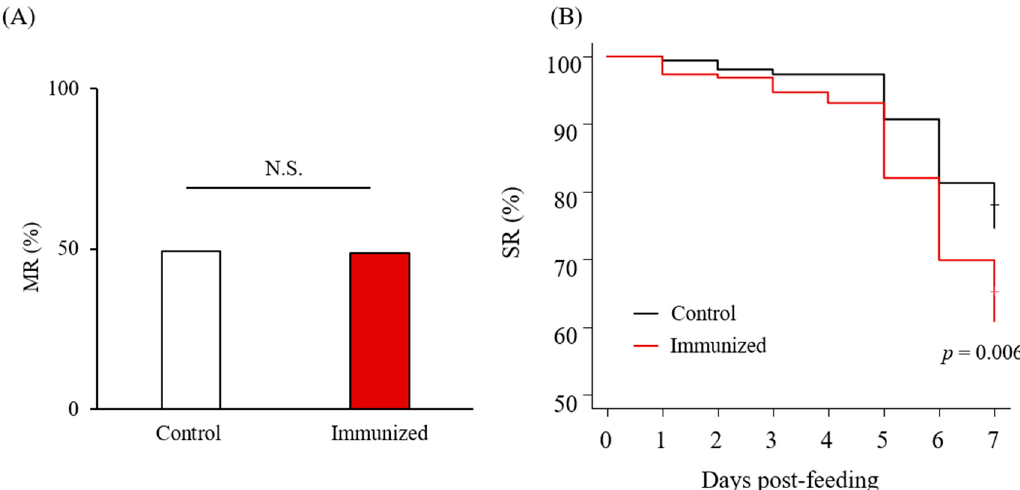
Figure 5. Anti-PRM effects of plasma from chickens immunized with Dg-Cys -his (second experiment). ( A ) The molting rate (MR) at seven days post-feeding was assessed. Statistical analyses were performed using Fisher’s exact test. ( B ) The survival rate (SR) of PRMs that were fed with the plasma from immunized chickens was assessed every day for a one-week period. Statistical analyses were performed using Log-rank test. p < 0.01 was considered statistically significant. N.S.: not significant.